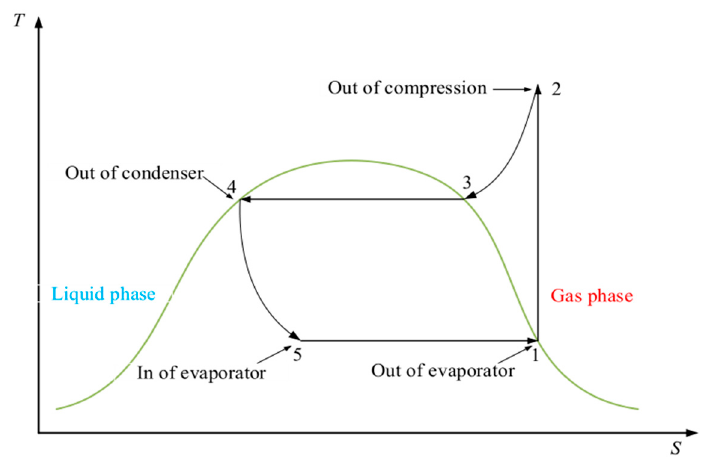
Figure 20. T-S diagram of the subcritical vapor compression heating working cycle.